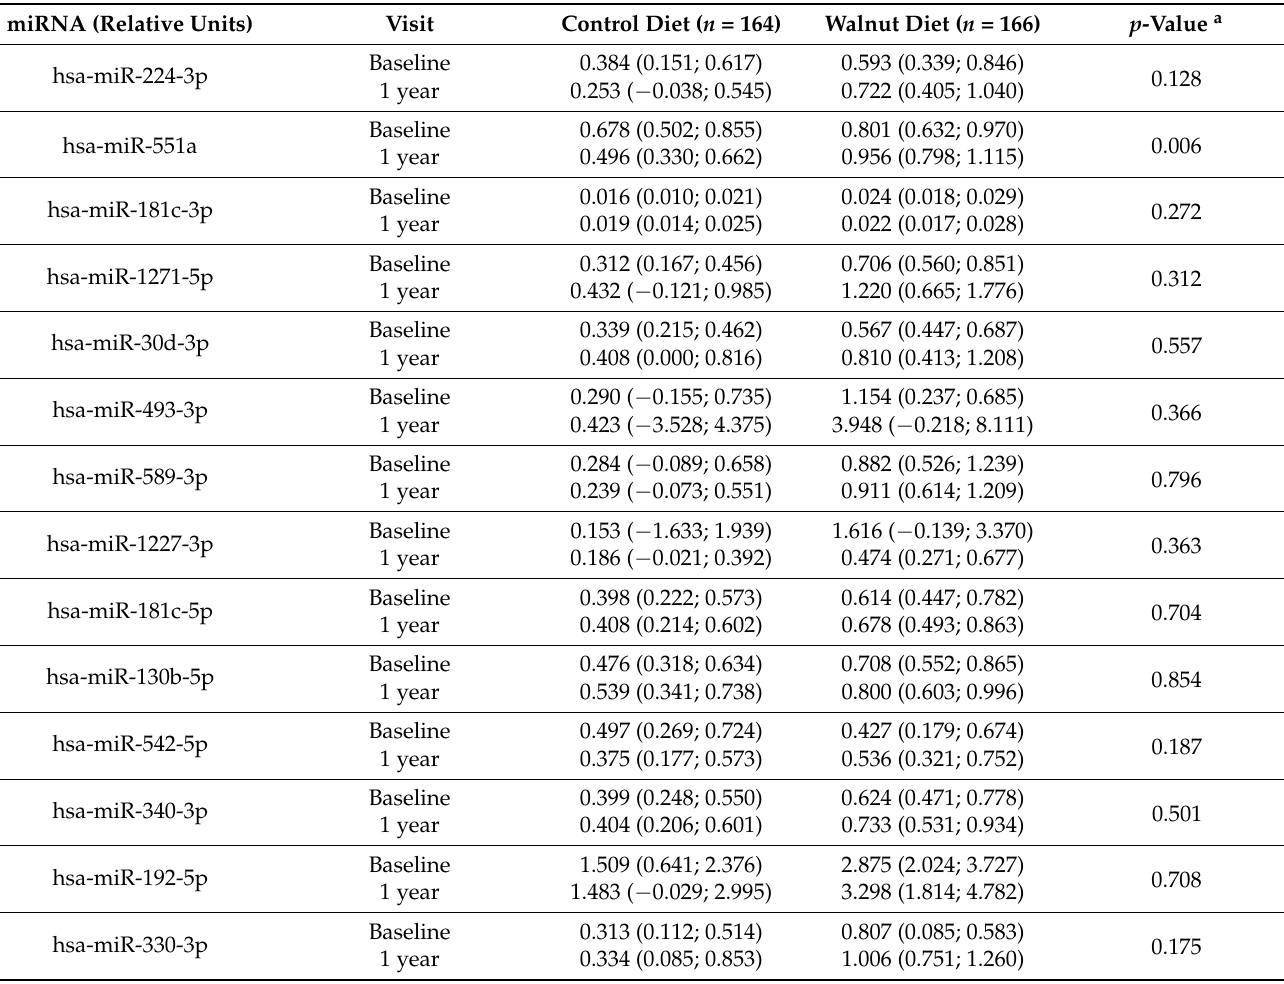
Table 4. Baseline and 1 y serum miRNAs by intervention